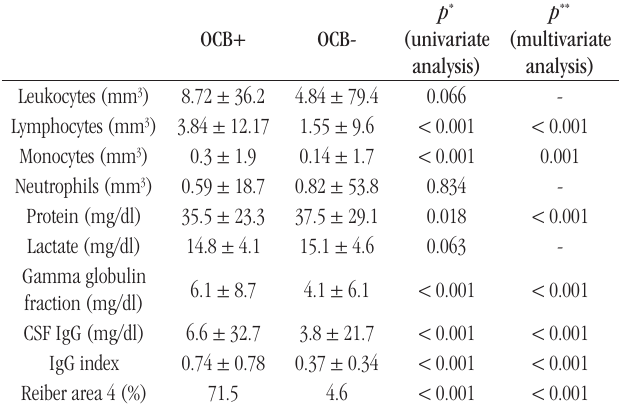
table – CSF data compared between OCB+ and OCB- samples